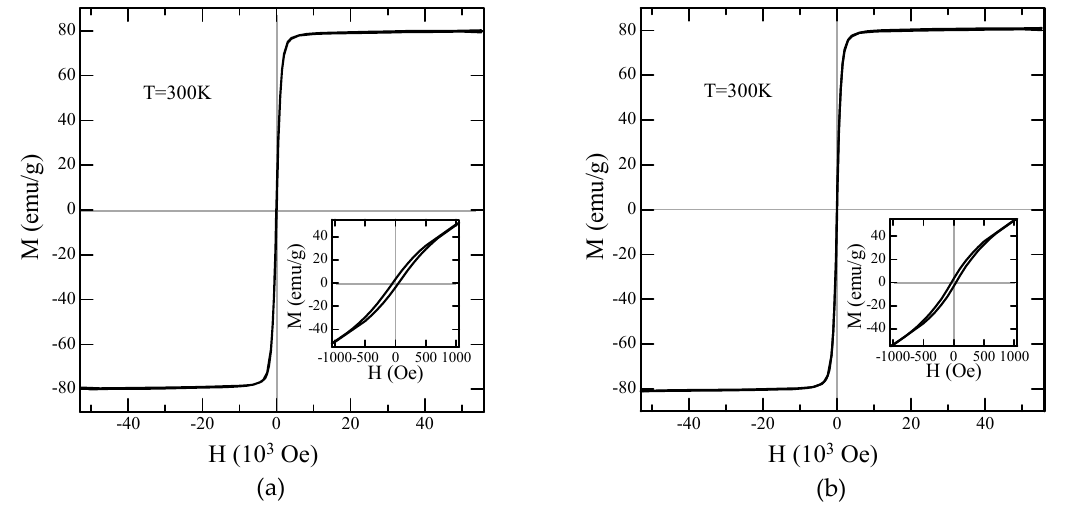
Figure 4. ( a ) Mass magnetization M as a function of the applied external magnetic field H measured for the spherical Fe 3 O 4 microparticles at 300 K. ( b ) Mass magnetization for the octahedral Fe 3 O 4 microparticles.